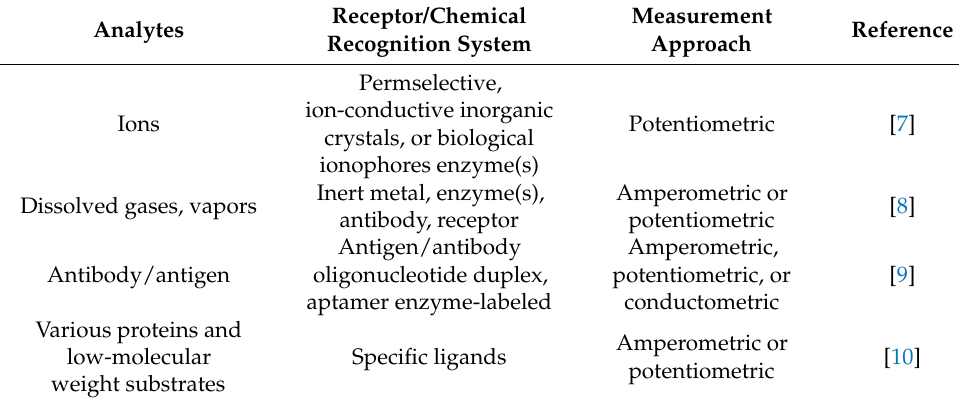
Table 1. Biosensor receptors and electrochemical measurement